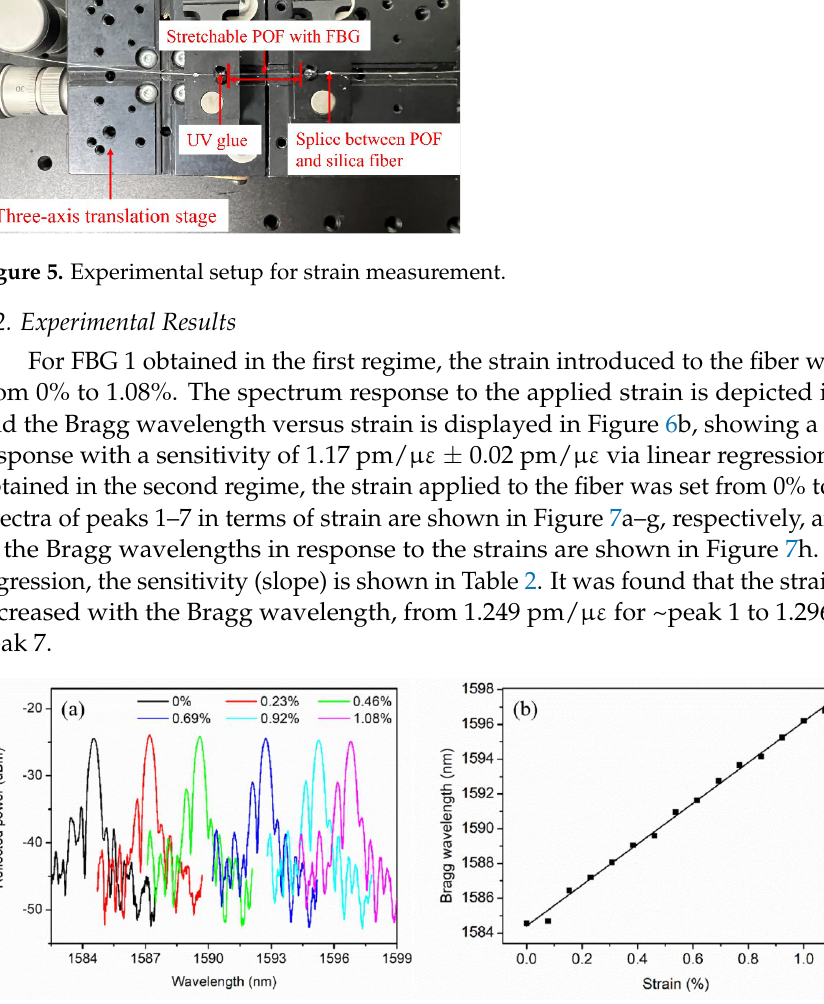
Figure 7. The spectra of peaks 1 – 7 ( a – g ) and Bragg wavelength shift ( h ) in terms of the strain from 0% to 1.05% for FBG 2 in the second regime.